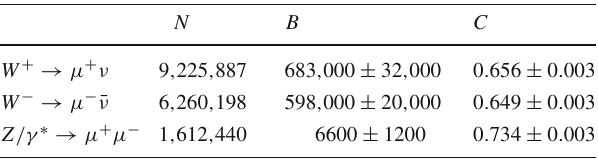
Table 4 Number of observed candidates N , of expected background events B , and the correction factors C for the W + , W − , and Z /γ ∗ (66 < m μμ < 116 GeV) muon channels. The correction factors C were defined in Eq. (6). The charge asymmetry in the background to the W ± channels stems from the W → τν contributions, which is proportional to the signal yield. The uncertainties are the quadratic sum of statistical and systematic components. The statistical uncertainties